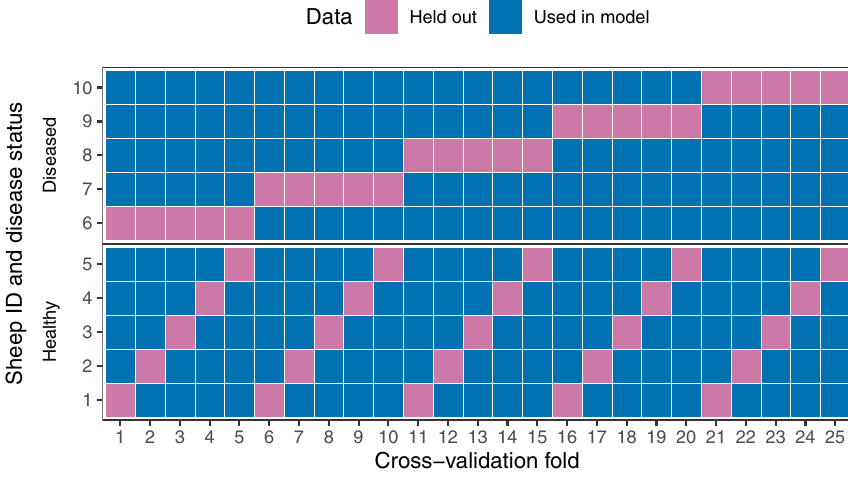
Figure 5. Schematic of cross-validation for machine learning models. The figure illustrates how data from each sheep were partitioned into modelling and holdout sets based on leaving out each of the 25 possible combinations of one healthy and one diseased